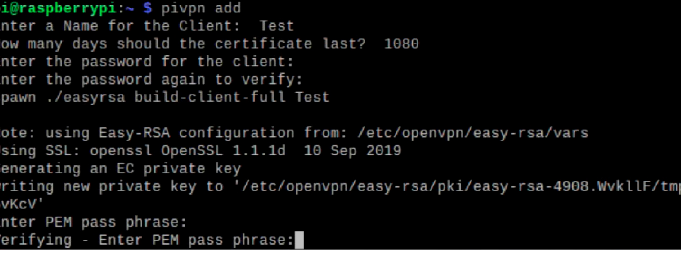
Figure 7. Prototype of Raspberry Pi and the water sensor connected with a breadboard. A process flow diagram for the operation of water sensors and valves is given in Figure 8. The “Calculate Percentage” node calculates the percentage of water level based on the data from the water sensor, and the result is transferred to the “Water Level” dashboard node to display the output on the mobile app dashboard for the monitor and control of water level remotely. An illustration of the output is shown in the dashboard is given in Figure 9. To perform an auto refill of water with “Valve l”, a rule is set, such as “if the water level is less than 15% of tank capacity, turn ON the valve; if the water level is greater than 80%, turn OFF the valve”. Valve 1 is then connected to a valve switch control “Water In” node that triggers the action accordingly with the status, “Statute” which is set to communicate “Water is refilling” if Valve 1 is ON, or “Water is ready to use” if Valve 1 is OFF.